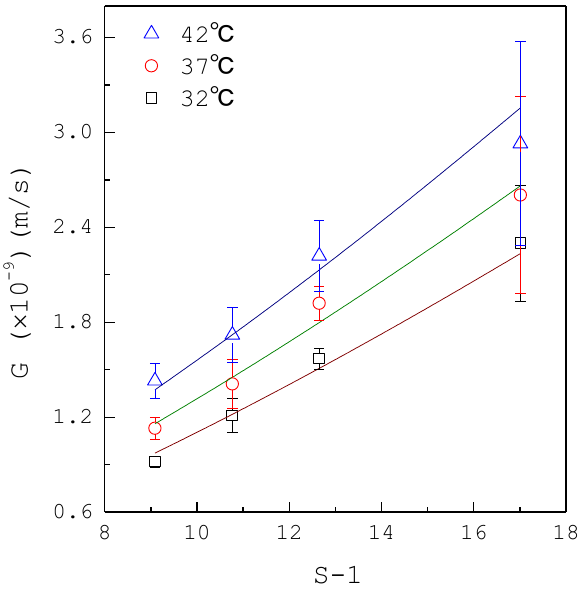
Figure 4. The growth rate data of calcium oxalate crystals without inhibitors. Each point represents the mean growth rate for eight crystals and the error bar represents the 95% confidence interval for the growth rate. Lines correspond to the best-fit regression of Equation (2).